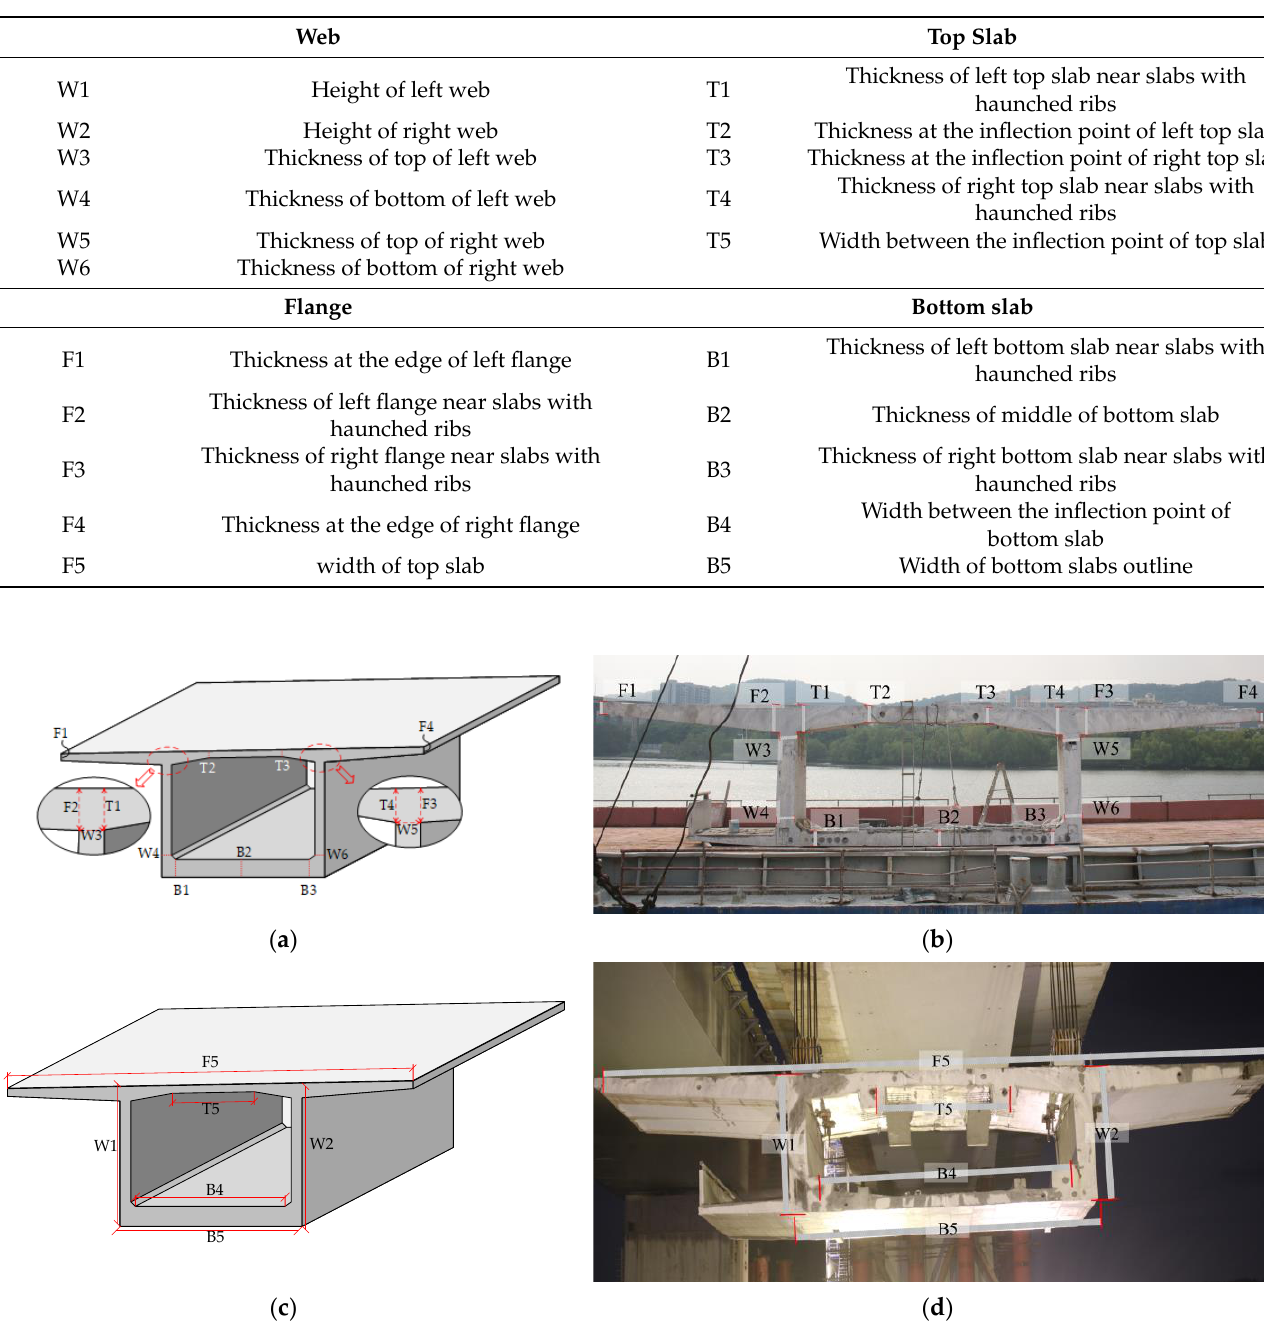
Table 3. Notations of sectional dimension and measurement position.